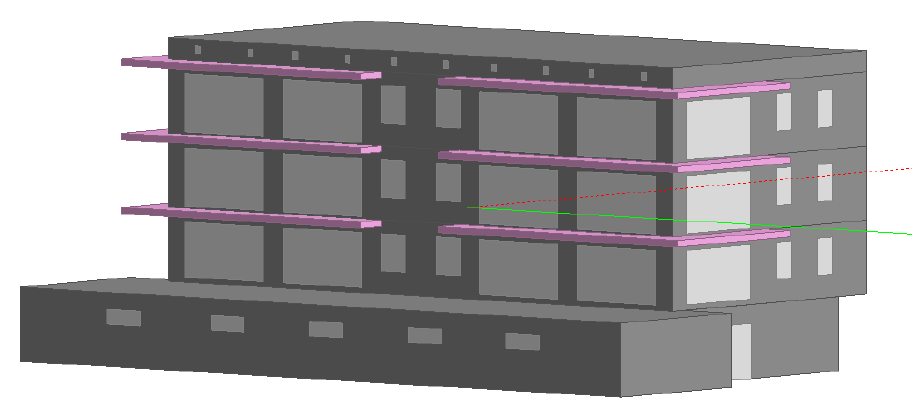
Figure 5. Model of the